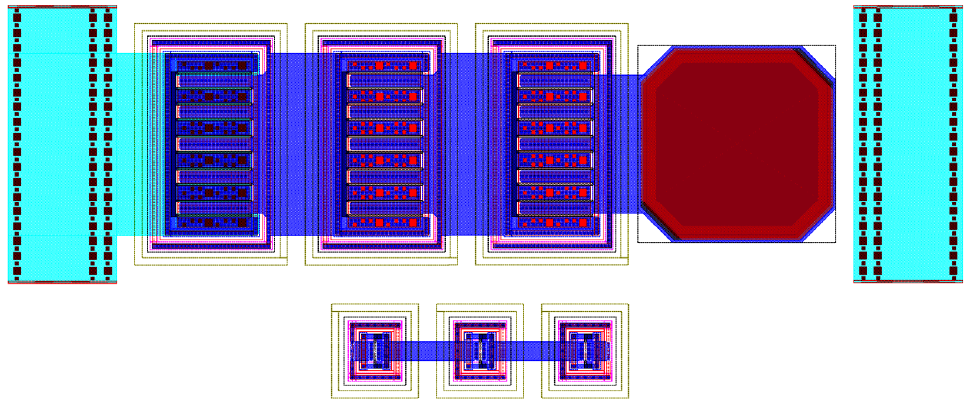
Figure 10. Pad-related ESD and local overvoltage structures based on the schematic presented in Figure 9 laid side by side on the same scale.